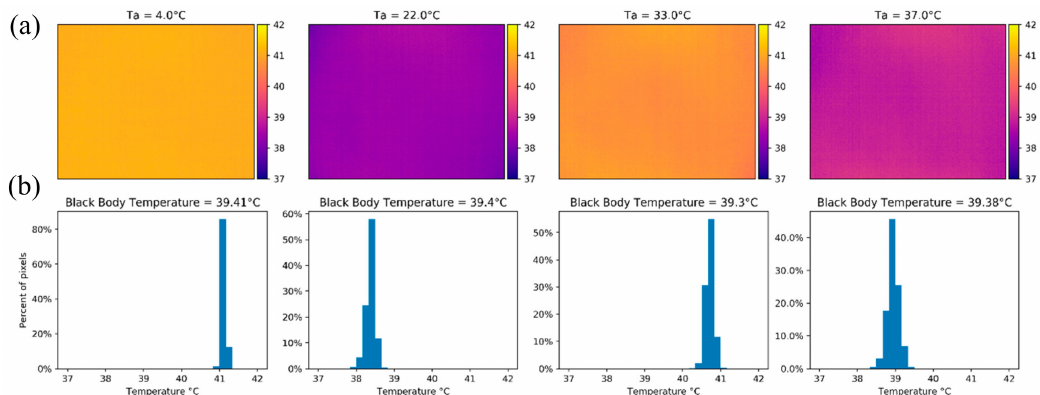
Figure 9. ( a ) Thermal images from the TeAx 640 with the β 1 coe ffi cient set to zero with similar black body temperature under the four ambient temperatures of the calibration experiment. ( b ) The corresponding histograms show an average dispersion lower than 0.106 ◦ C from the mean values (41.13, 38.37, 40.71, 38.95 ◦ C respectively).